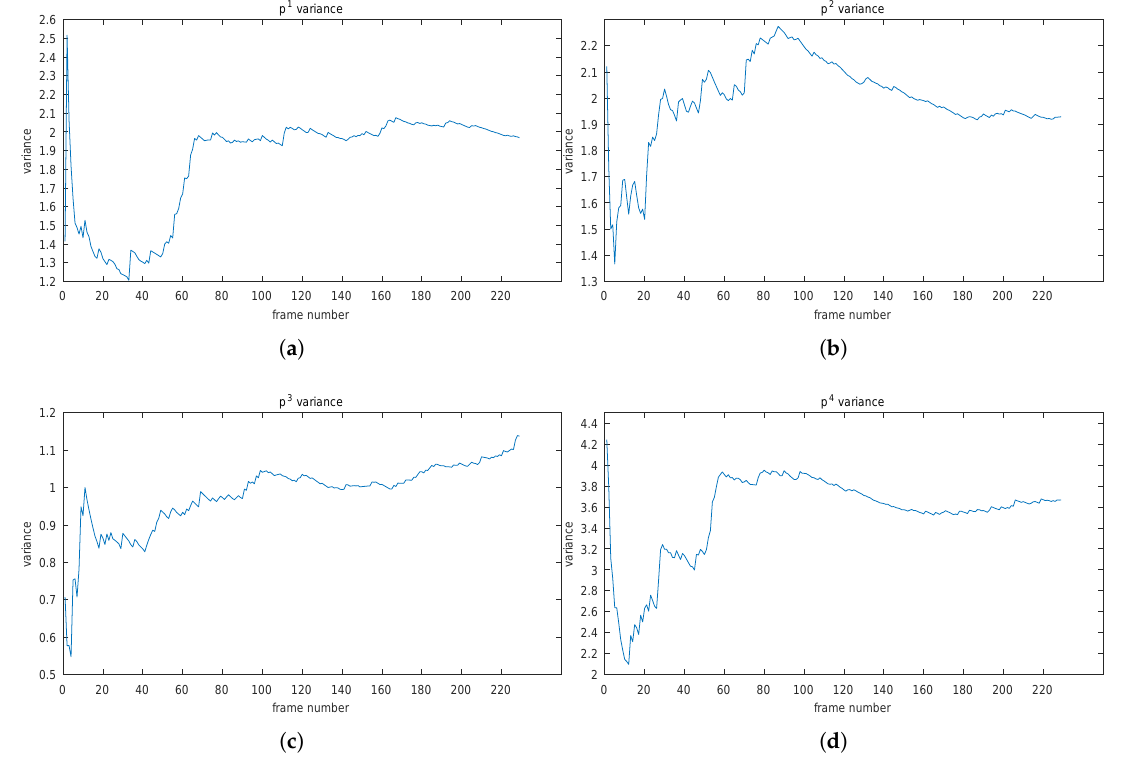
Figure 2. VCS tendencies of points mentioned in Figure 1 are showed in ( a – d ), separately. When the tendency reaches a stable status, the Y -axis value is also called the convergent value ( cv